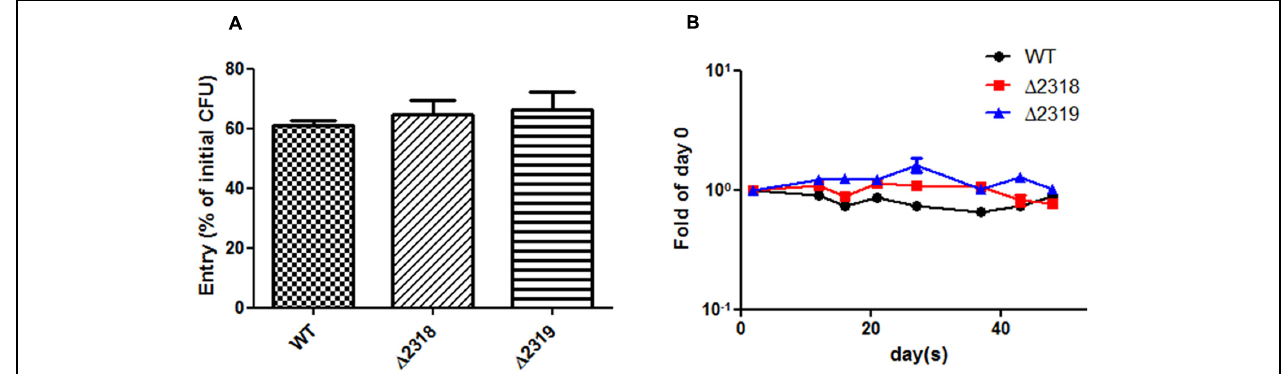
FIGURE 5 | Entry and growth of M. marinum inside Dictyostelium. (A) The entry of M. marinum wild-type, (cid:2) 2318 and (cid:2) 2319 into Dictyostelium . The bacteria numbers inside Dictyostelium cells on 2 h post infection at MOI = 10 were determined. Entry was represented as the percentage of entry CFU versus initial CFU of three independent experiments. The two deletion mutants ( (cid:2) 2318 and (cid:2) 2319 ) had no significantly different entry rate in comparison with wild type. Data from three independent experiments are presented as the mean ± SEM of the % of initial CFU. (B) Growth kinetics of the M. marinum wild-type, (cid:2) 2318 and (cid:2) 2319 strain inside Dictyostelium . The bacteria numbers inside Dictyostelium on different hours (2, 12, 16, 21, 26, 37, 43, 48) post infection at MOI = 10 were determined. Data from three independent experiments are presented as the mean ± SEM of the fold of initial entering bacteria number.